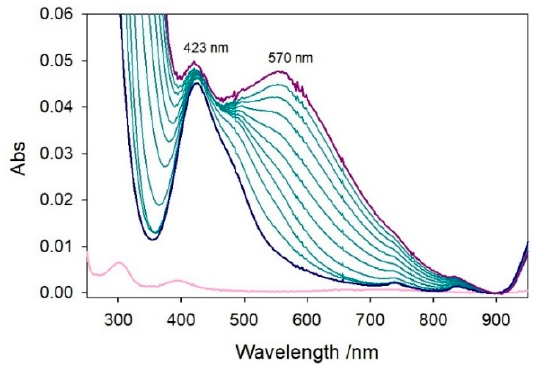
Figure 7. Titration of nickel(II)–A β 4–16 complex (blue spectrum, at 1:1 ratio, 0.5 mM) with 0.0–0.55 mM copper(II) (final point as violet spectrum) in 5 mM phosphate buffer solution at pH 7.4. The pink spectrum corresponds to the absorption of free nickel(II).